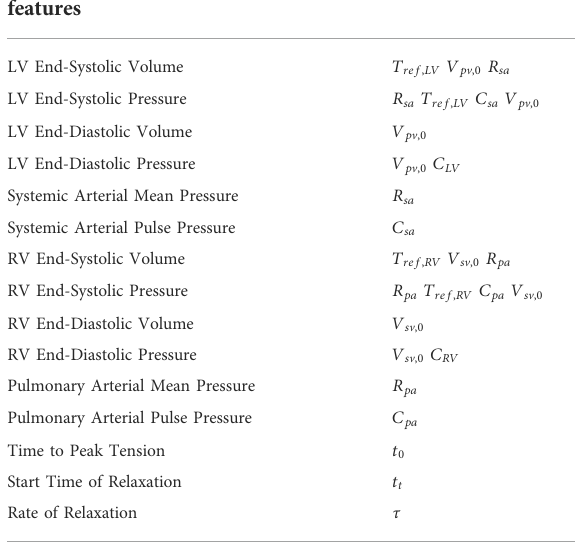
TABLE 3 Hemodynamic metrics and tuned parameters of the high- resolution ventricular models. Hemodynamic metrics &